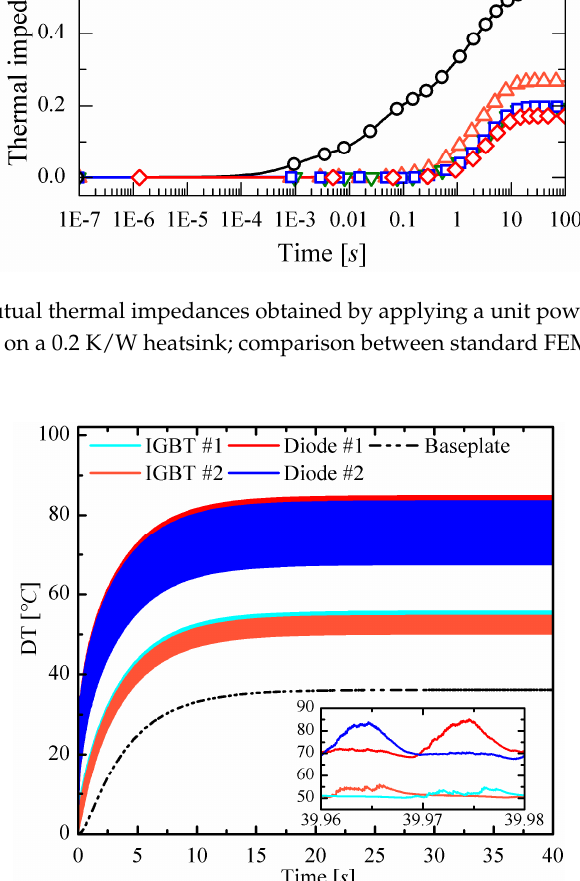
Figure 9. Estimated variation of IGBTs, diodes, and baseplate temperature rises for the module mounted on a 0.2 K/W heatsink. The inset shows that swings are much wider than those reported for the previous case in Figure 6.